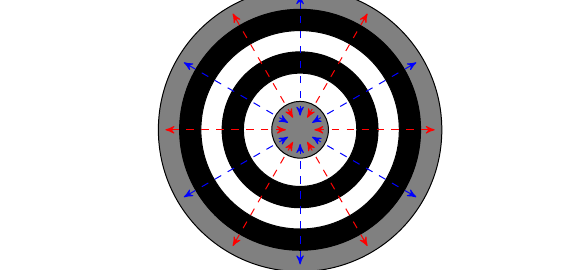
Figure 27 . Expected phase space density describing a pair of entangled superstars, with dashed arrows stressing the existence of additional correlations between regions of phase space that are properly encoded in the N-particle phase